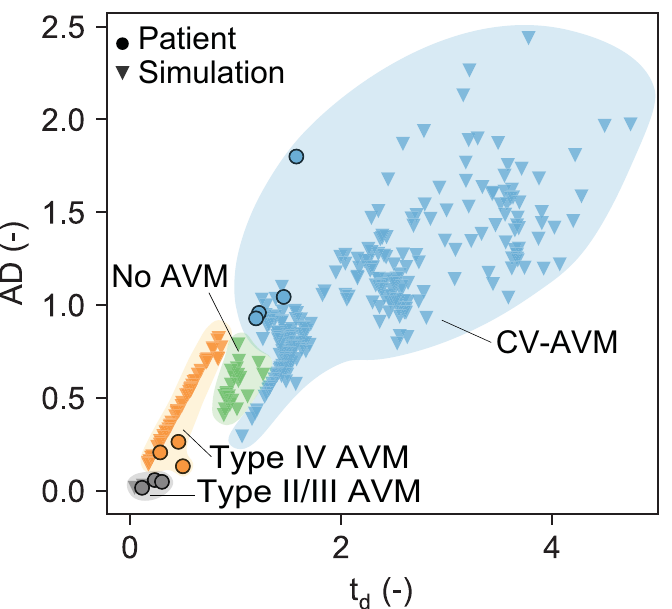
Fig 7. AD and t d values for computational AVM models and patient cases. Scaled AD (absolute dispersion) and t d (total delay) for baseline (green triangles), type IIIb (grey triangles), type IV (orange triangles), type CV (blue triangles) and type IIIb (grey triangles) computational models (n = 315) and type IV (orange circles), type CV (blue circles) and type I/III (grey circles) patient cases (n = 10). range of 0.1–0.8 and t < 1. In this case, all AD values above 0.4 (and t > 0.4) are observed in d d type IV models, where fistulae are either small in number or feeding from distal nodes of the arteriolar tree. CV-AVMs result in t (cid:21) 1 and AD (cid:21) 0.3. All CV-AVM cases with similar AD d values as the baseline (0.3 (cid:20) AD (cid:20) 0.8) correspond to model networks with small venular dila- tion (i.e. x < 3). At the other end of the parameter range, AD and t can become arbitrarily factor d